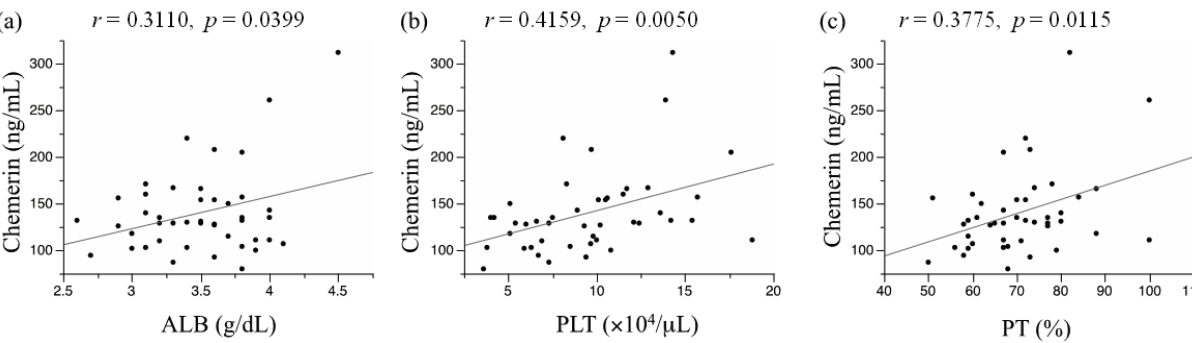
Figure 1. Association between serum chemerin levels and ( a ) serum albumin level; ( b ) platelet count; ( c ) prothrombin time; ( d ) Child-Pugh score; ( e ) serum alanine aminotransferase level; and ( f ) serum total bilirubin